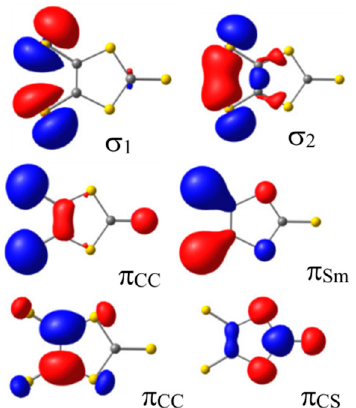
Figure 3. Valence occupied and virtual σ and π orbitals of dmit − 2 ligand that can be combined with M 3d orbitals.